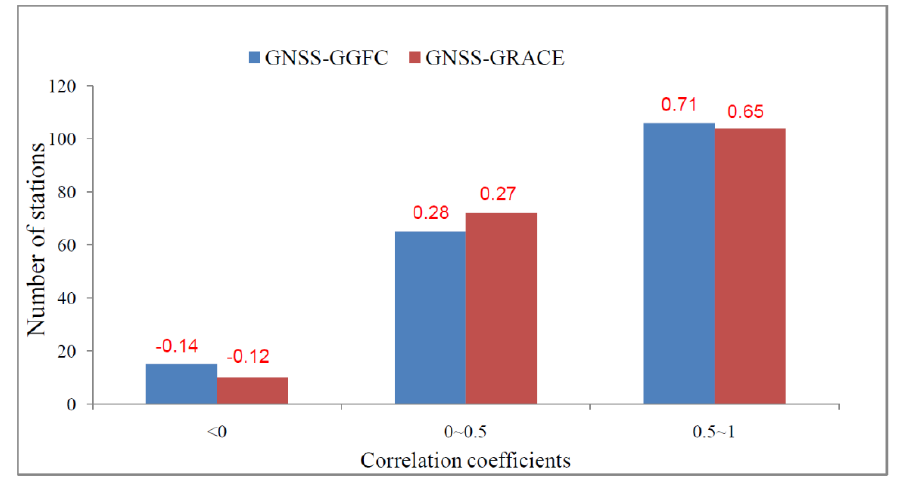
Figure 5. Histogram of statistical results for the correlation coefficients (the red text above the histogram represents the average of the correlation coefficients).